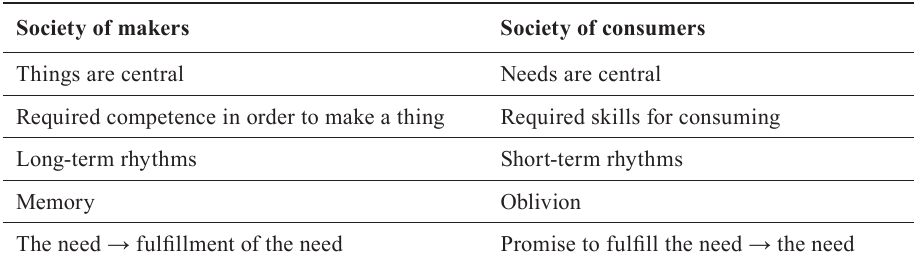
table 1. the difference between the society of makers and society of consumers according to Zygmunt Bauman Society of makers Society of consumers things are central Needs are central Required competence in order to make a thing Required skills for consuming long-term rhythms Short-term rhythms memory Oblivion The need → fulfillment of the need Promise to fulfill the need → the